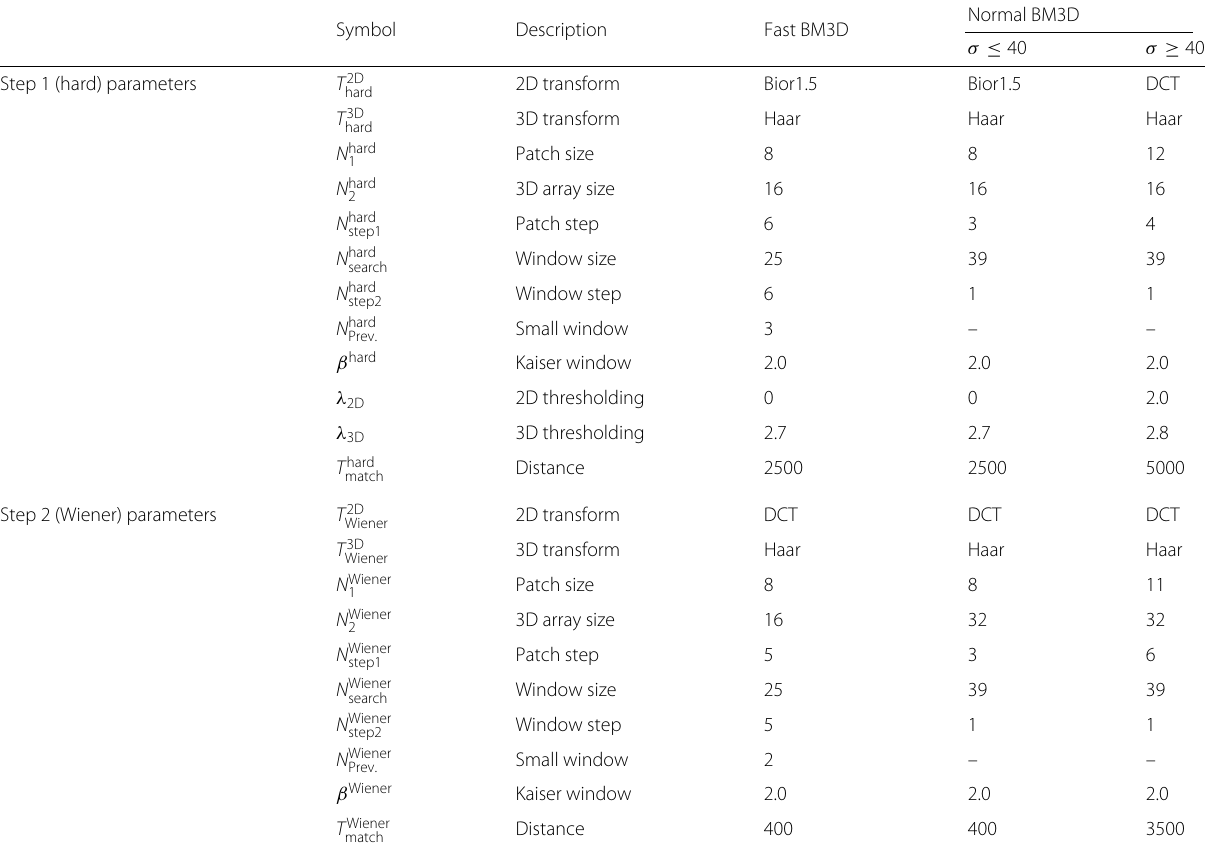
Table 1 Parameters set for the original